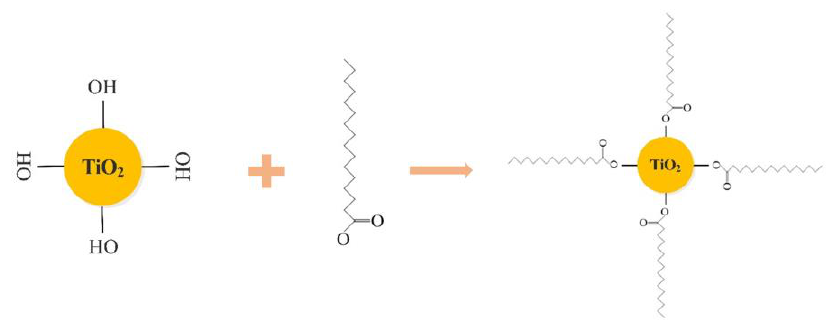
Figure 6. Schematic of stearic acid interaction with TiO 2 .